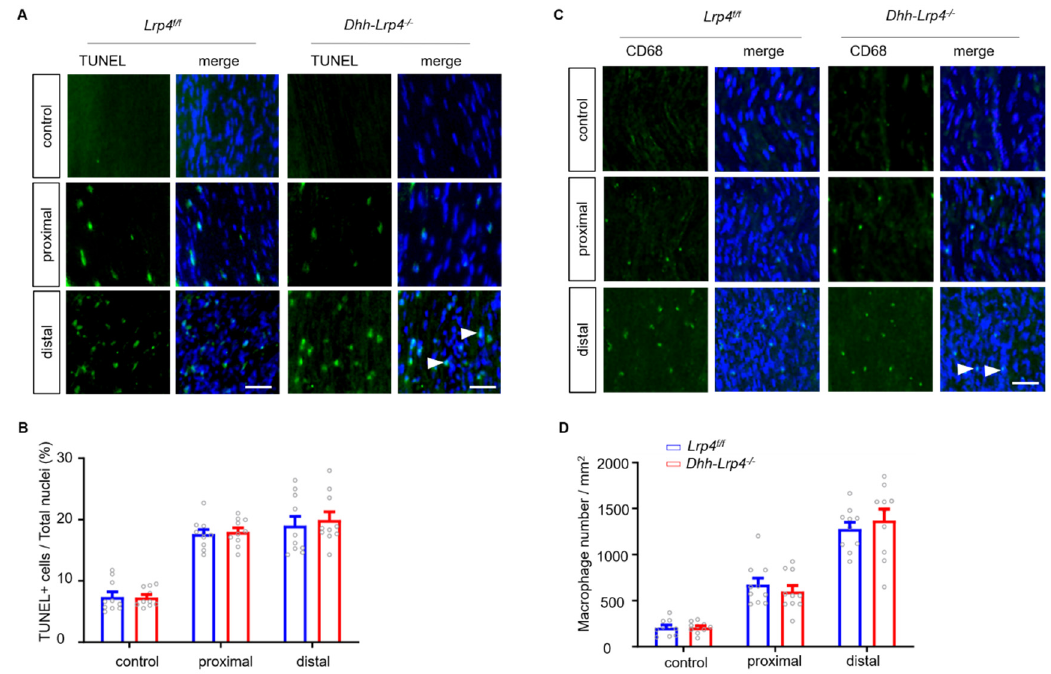
Figure 6. Lrp4 ablation in SCs does not influence SC survival or macrophage recruitment after injury. ( A ) The numbers of TUNEL-positive cells in the sham control and proximal and distal ends of crushed nerve segments did not differ between the control and cKO mice. The white arrows indicate the apoptotic cells . Scale bar = 25 μ m ( B ) The proportion of TUNEL-positive cells was not significantly different between the control and cKO mice. Control and cKO, n = 10 slices, 3 mice/group. ( C ) Representative pictures of macrophages from control and cKO mice. The macrophage numbers in the sham control and proximal and distal ends of the crushed nerve segments did not differ between the control and cKO